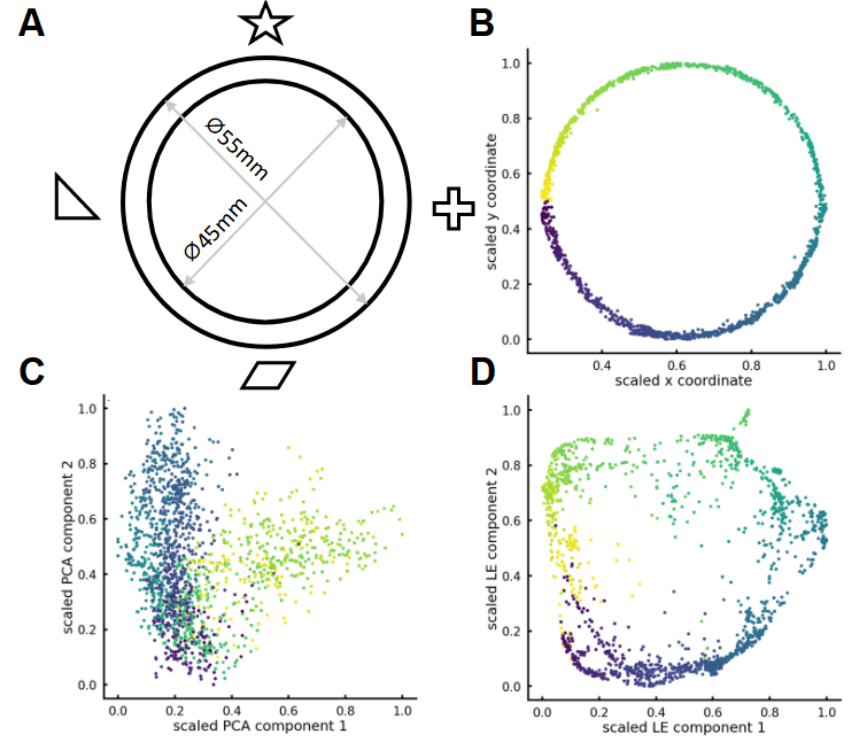
Figure 5. ( A ) Round track with visual cues, ( B ) pointwise track representation, ( C ) first two axes of PCA embedding, ( D ) first two axes of LE embedding (eigenvectors of the graph